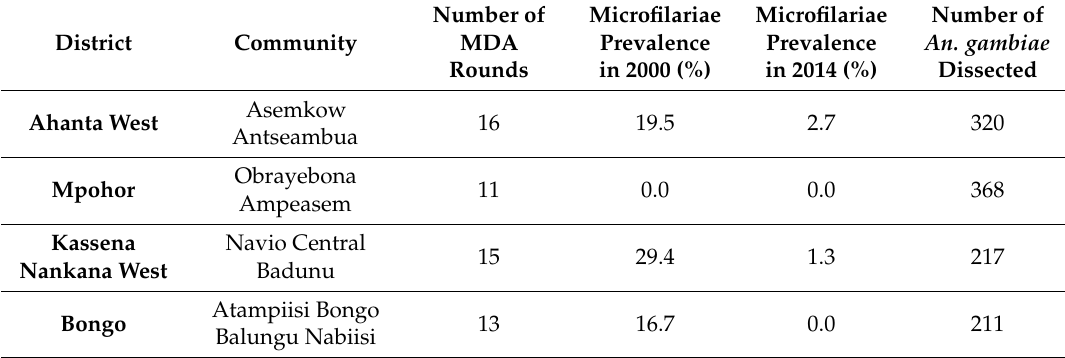
Table 1. Number of mass drug administration (MDA) rounds and prevalence of microfilariae in the four districts of Ghana where the current study was conducted between July 2015 and July 2016. Number of Microfilariae Microfilariae Number of An. gambiae Prevalence Prevalence District Community MDA Dissected in 2014 (%) in 2000 (%) Rounds Asemkow Ahanta West 16 19.5 2.7 320 Antseambua Obrayebona Mpohor 11 0.0 0.0 Ampeasem Kassena Navio Central Nankana West Badunu Atampiisi Bongo Bongo Balungu